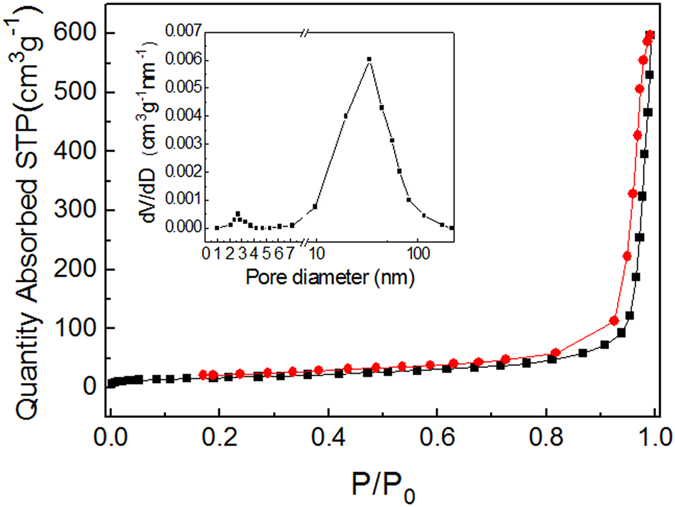
N2 adsorption-desorption isotherm for the ZnO/ZnFe2O4 nanoparticles (inset is the pore size distribution).